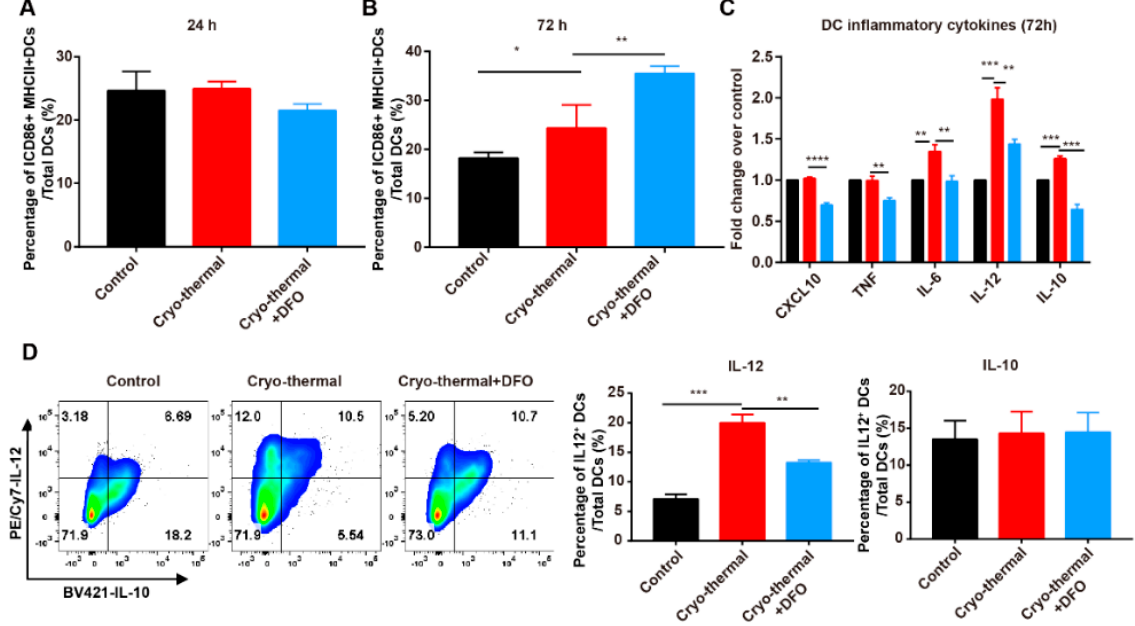
Figure 6. Iron promotes DCs maturation. Mice were sacrificed and spleens were harvested 24 h and 72 h after cryo-thermal therapy. ( A , B ) The percentages of mature DCs (CD86 + MHC II + ) were measured by flow cytometry. ( C ) DCs were sorted and the expression levels of CXCL10, TNF, IL-6, IL-12 and IL-10 were determined by RT-qPCR. ( D ) Intracellular IL-12 and IL-10 in DCs were determined by flow cytometry. * p < 0.05, ** p < 0.01, *** p < 0.001, **** p < 0.0001, n = 3 for each group.